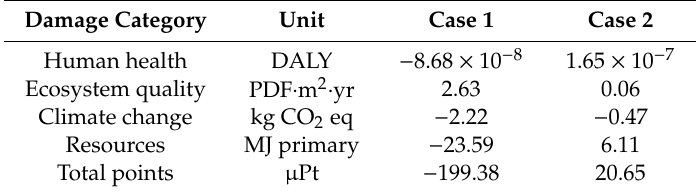
Table 5. IMPACT 2002 + endpoint results (per ton of